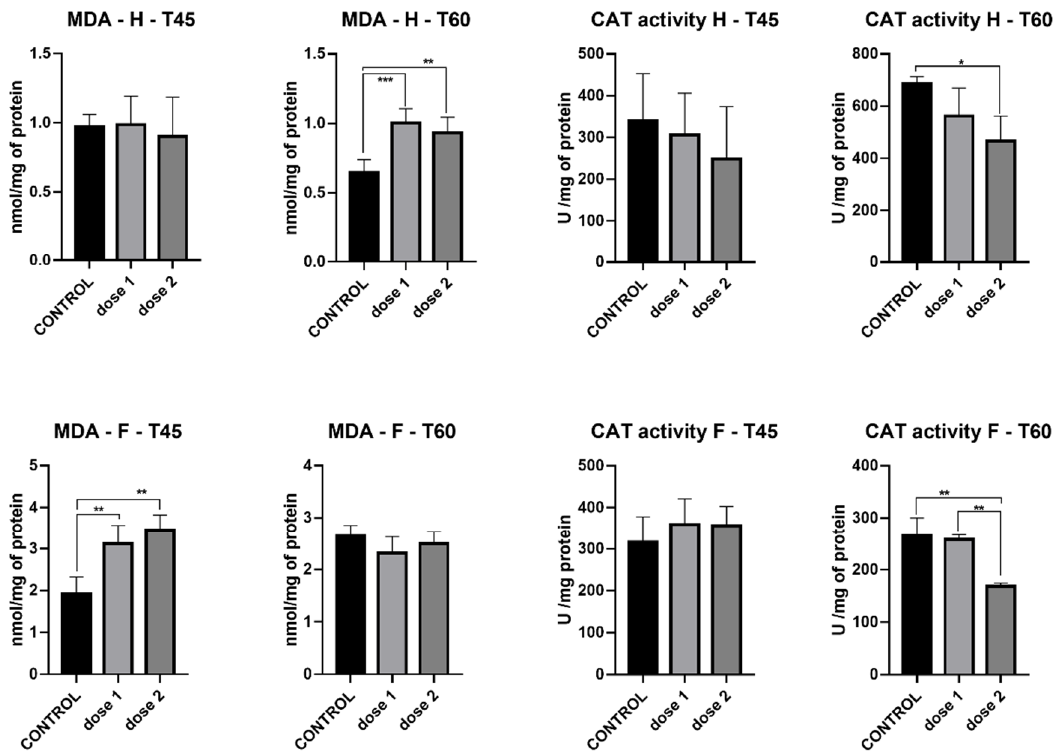
Figure 6. Malondialdehyde levels and catalase activity in the hippocampus (H) and frontal cortex (F) of groups sacrificed immediately after treatment (T45) and those sacrificed 15 days post-treatment (T60). * p < 0.05; ** p < 0.01; *** p < 0.001. Catalase activity measured in the hippocampus presented a decrease in both treatment groups compared to control, with significant a difference present only at T60; D2 ( p < 0.05). In the frontal lobe, at T45, catalase activity was similar between control and treatment groups, while at T60, a marked decrease was registered in D2 ( p < 0.01) (Figure 6). GSH levels measured in the hippocampus showed a dose-dependent drop at T60, where statistical significance was observed in D1 ( p < 0.01) and D2 ( p < 0.001). GSSG levels at T45 were markedly higher at D1 ( p < 0.001) and D2 ( p < 0.001) compared to control, whereas at T60, a dose-dependent decrease was observed, with statistical significance in D2 ( p < 0.05). The GSH/GSSG ratio significantly decreased in both treated groups ( p < 0.001) at T45, while at T60, only a slight yet statistically significant reduction was observed in D2 ( p < 0.05) (Figure 7). GSH levels measured in the frontal lobe showed a significant dose-dependent drop (D1: p < 0.001 and D2: p < 0.0001) at T45, which did not remain constant at T60, where levels evened out between treated and control groups. GSSG levels at both T45 and T60 showed no statistical difference between control and treated groups. The GSH/GSSG ratio